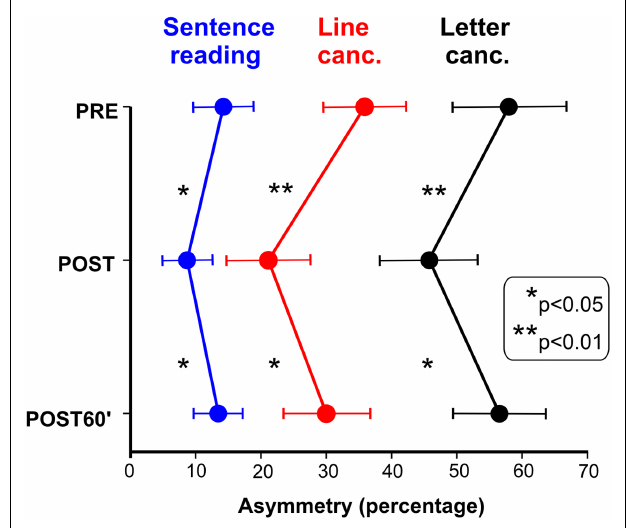
FIGURE 1 | Effect ofTENS on neglect patients’ performances in sentence reading, line cancelation, and letter cancelation tests . Scores: percent of omitted left minus right targets (positive values indicated more omissions in the left side of